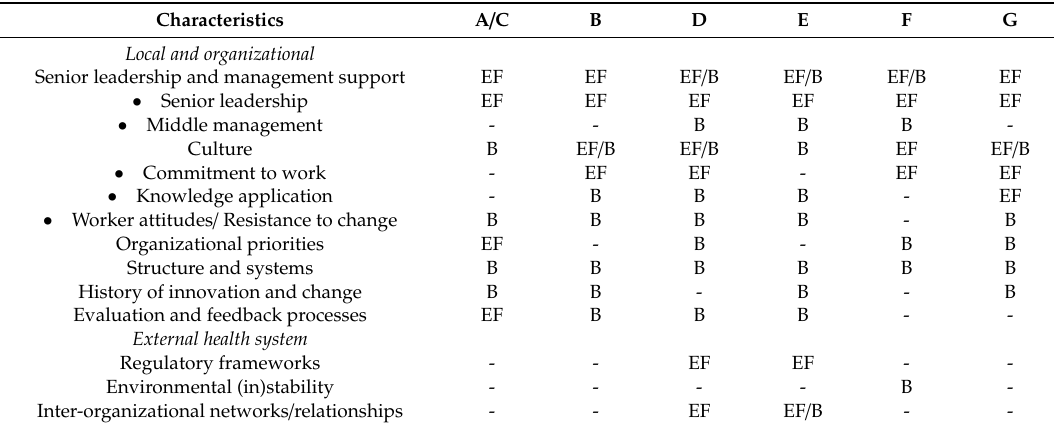
Table 4. Context construct characteristics and whether they were enabling factors (EF) and / or barriers (B) to the implementation of HealthWISE in each participating hospital